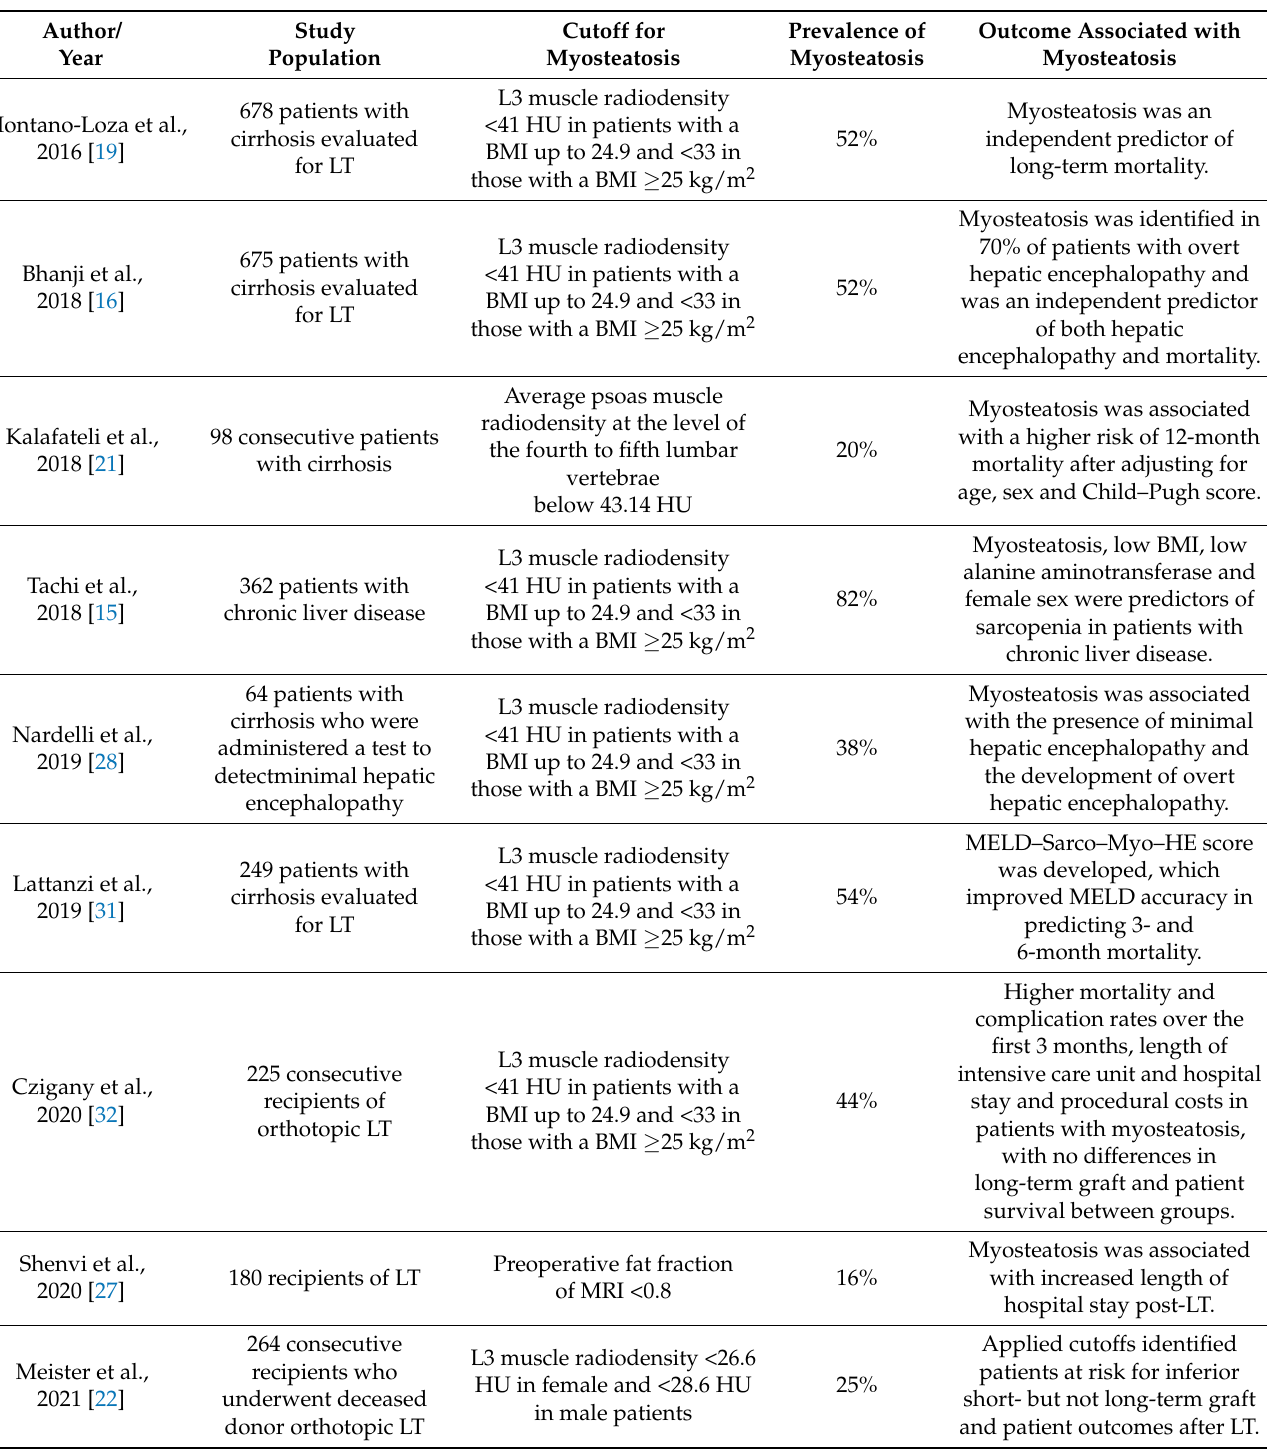
Table 1. Summary of studies investigating clinical significance of myosteatosis in